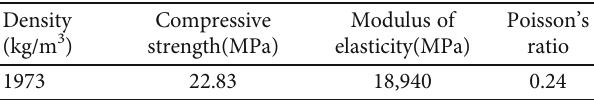
Table 1: Physical properties of